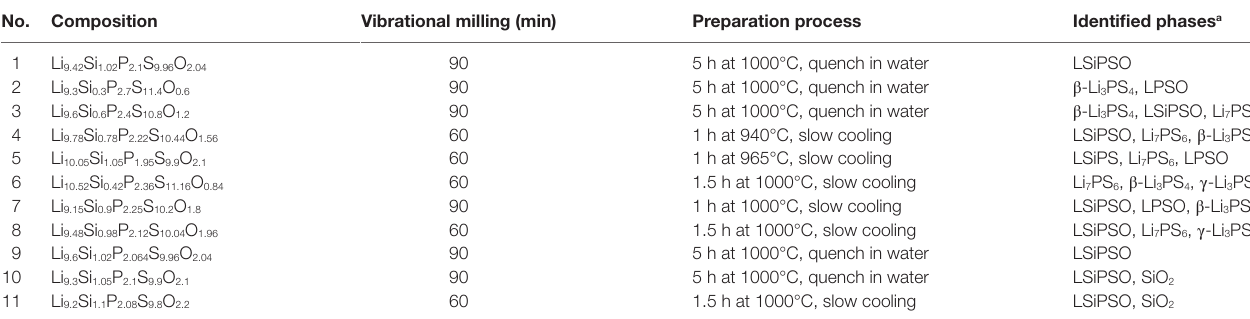
Table 1 | Methods used to prepare the various samples in the li 2 s–P 2 s 5 –siO 2 system synthesized in this study. no. composition